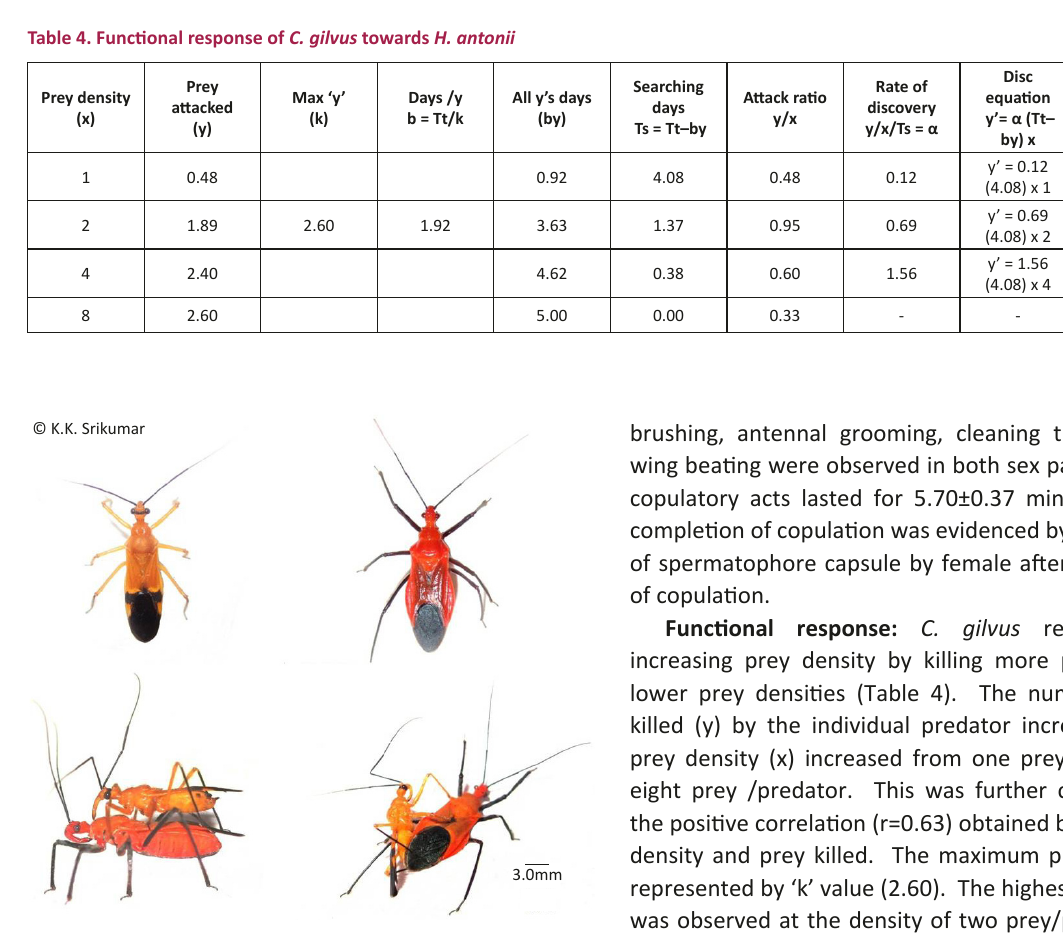
Image 3. C. gilvus : (a) male, (b) female, (c) riding over and (d) copulation